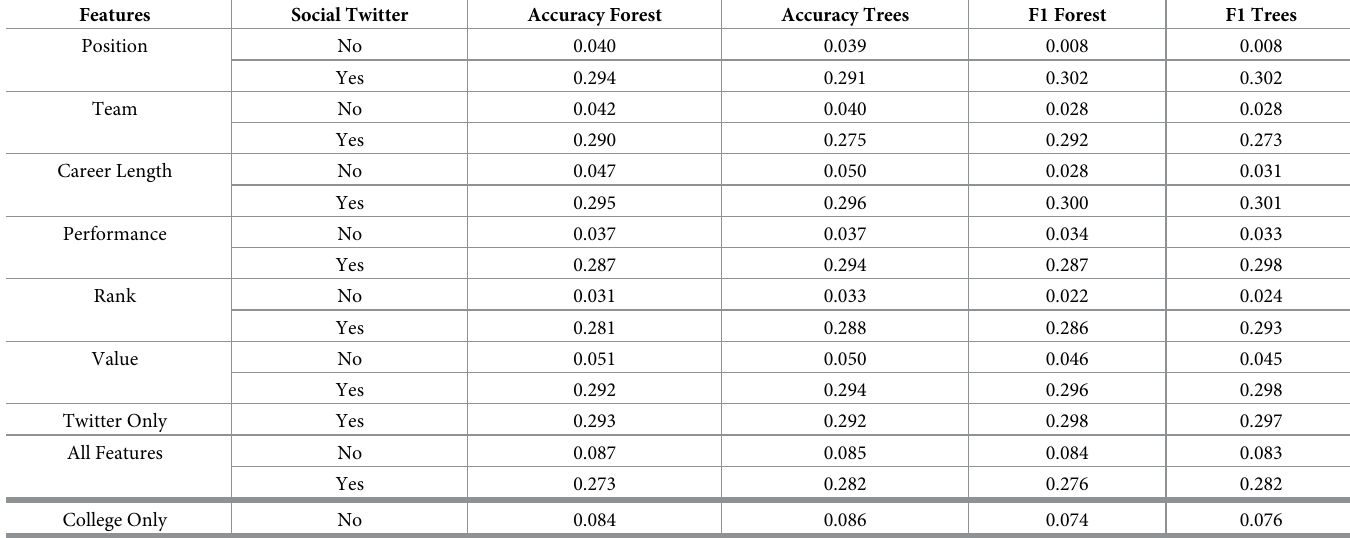
Table 9. Basketball inference and prediction results: (Top) The inference accuracy and F1 score is shown for team transition in the NBA during the time period 2001–2019 for players who had Twitter accounts . Each row indicates the feature(s) used. We note that a “yes” in the social column means Twitter data was used. (Bot- tom) The prediction accuracy and F1 score using the players’ college data to predict team transitions during 2001–2019 is